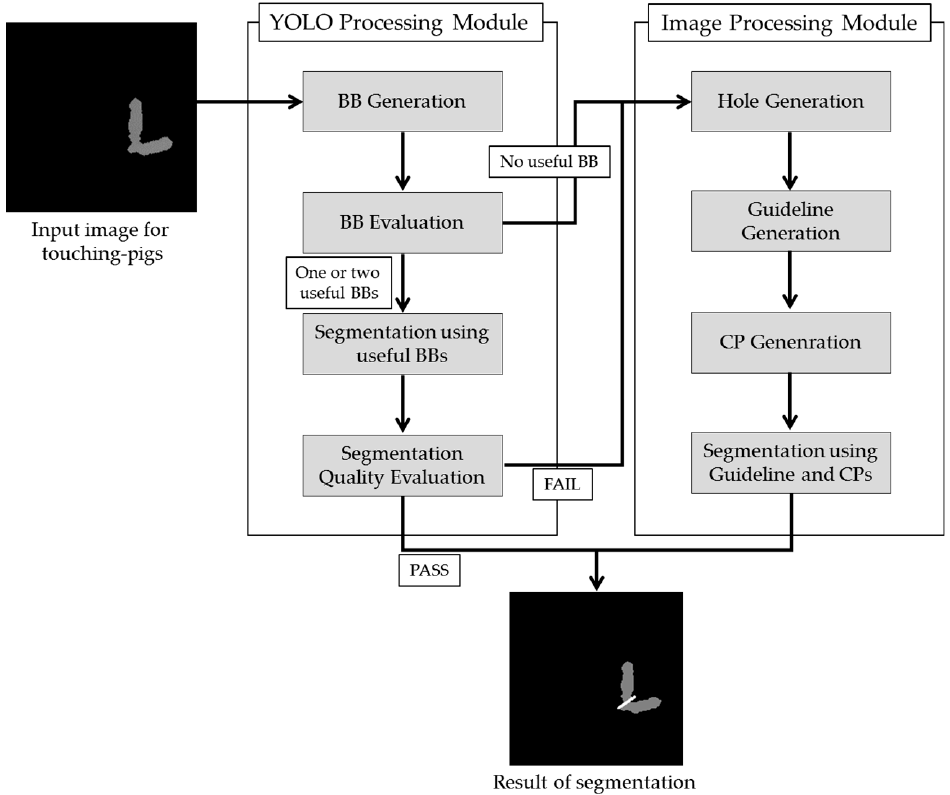
Figure 3. Overview of the proposed method.